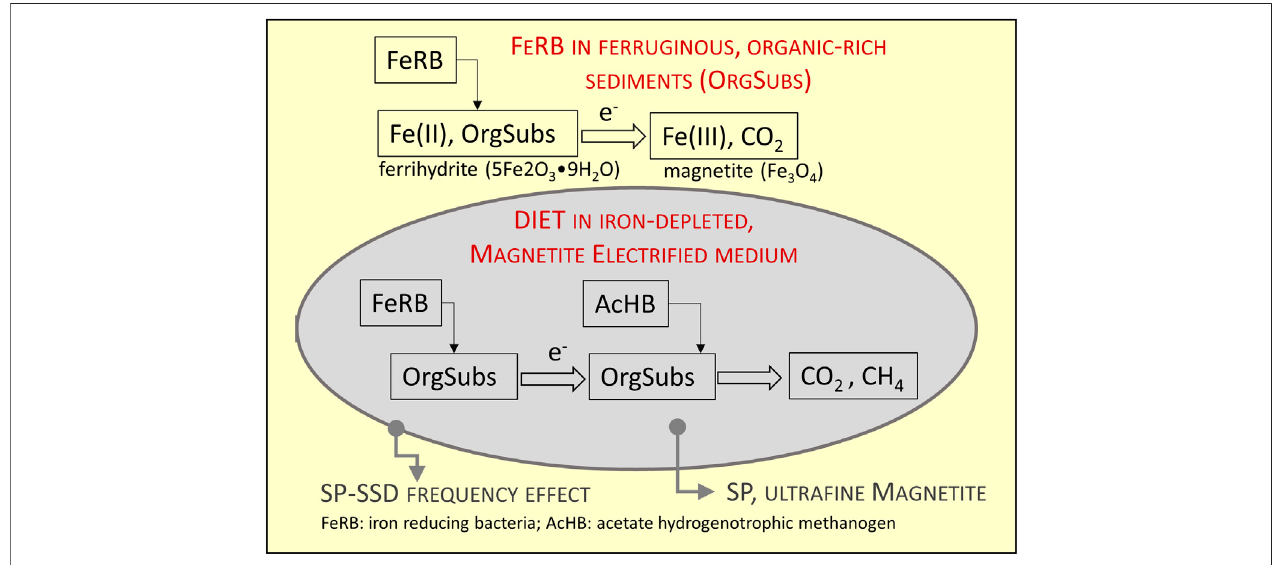
FIGURE 7 | Conceptual model illustrating the magnetic signatures observed across the methane pockets. The transformation of ferrihydrite into magnetite by iron reducing bacteria and the electron transfer to methanogens archaea. The DIET zone in this case is identi fi ed by a region of high SP content, surrounded by coarser particles within the SP-SSD